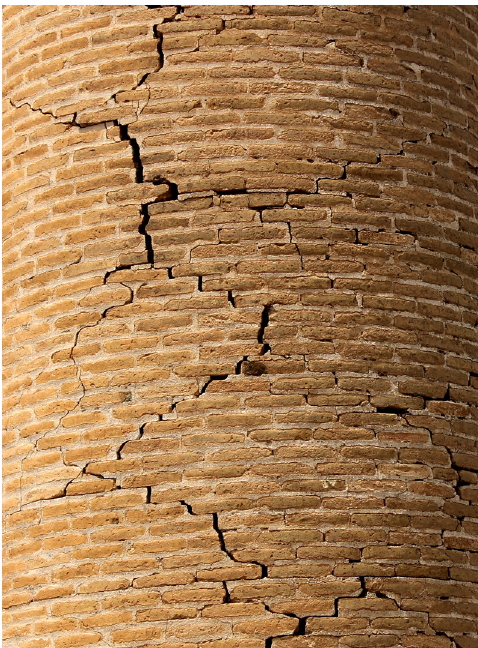
Figure 8: Detail of the textured model showing the cracks of the chimney (source: prepared by the